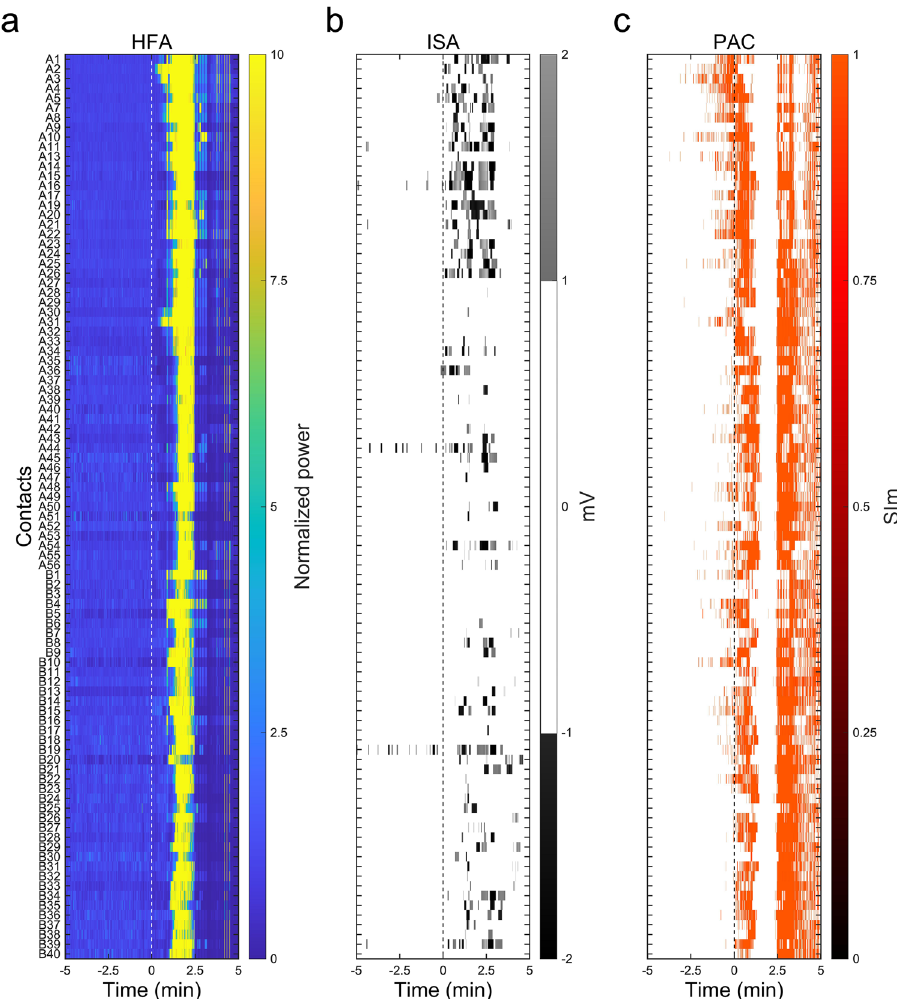
Figure 2. The topographies of HFA, ISA, and ISA-HFA SIm (PAC) of seizure 1 in Patient 1. The seizure-related data from 5 min before to 5 min after the SO (0 min) of seizure 1 (S1) in Patient 1 (P1) are shown. All contacts of P1 are shown. In Fig. 1, we only used the A2 contact that was placed in the SOZ. ( a ) The HFA-normalized power began increasing from the A2 contacts after SO and spread to other contacts. ( b ) Significant seizure- related ISAs, which are defined as more than 1 mV or less than − 1 mV, are indicated in grayscale. HFA and ISA occur after SO; however, no clear HFA or ISA occurs before SO. ( c ) Only significant SIm between the ISA phase and the HFA amplitude, which was obtained using the FWE-corrected threshold that was applied to the raw SIm, are shown. We observed significant ISA-HFA SIm, even before